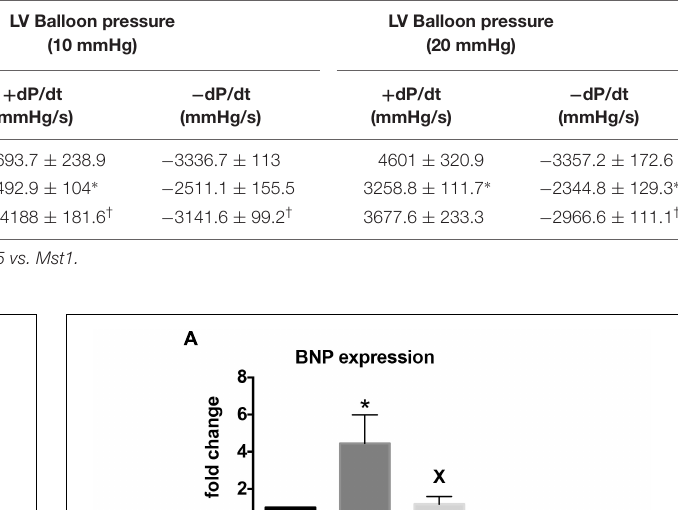
TABLE 3 | Contractile function in isolated perfused hearts.